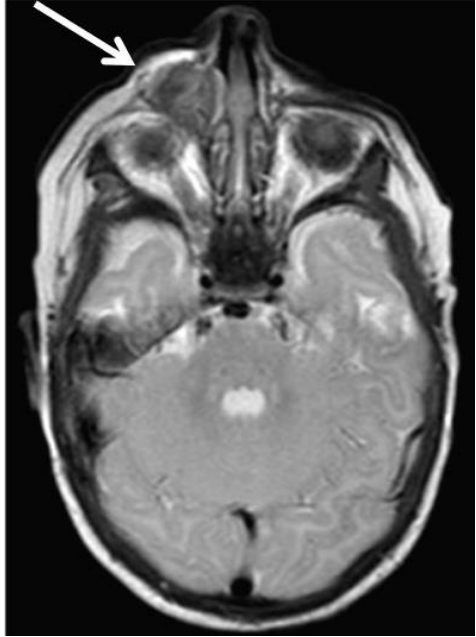
Figure 2. Patient 1: an axial T2-weighted MR scan shows well-defined pathological solid mass originating from the alveolar process of the right maxilla.